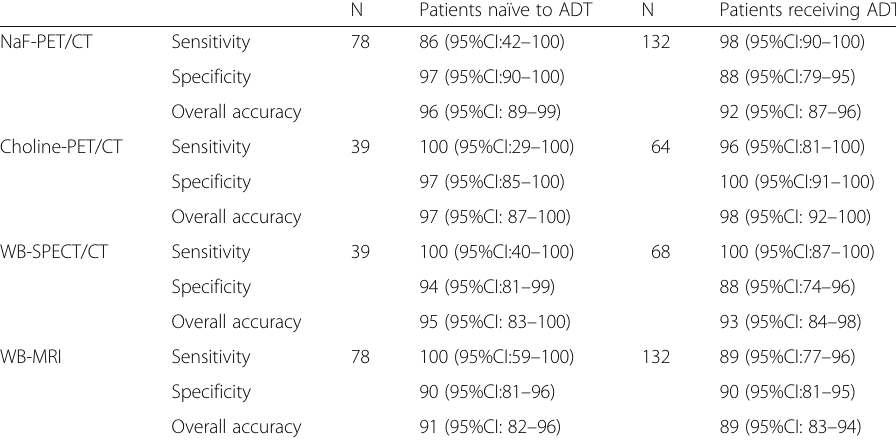
Table 4 Comparison of diagnostic performances - Patients naïve to ADT vs patients receiving ADT N